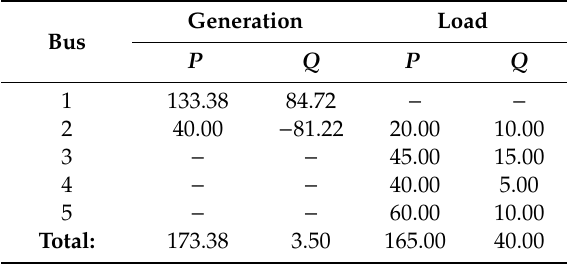
Table A18. Results of the mixed AC / DC PF calculations in Case 5. AC bus data.